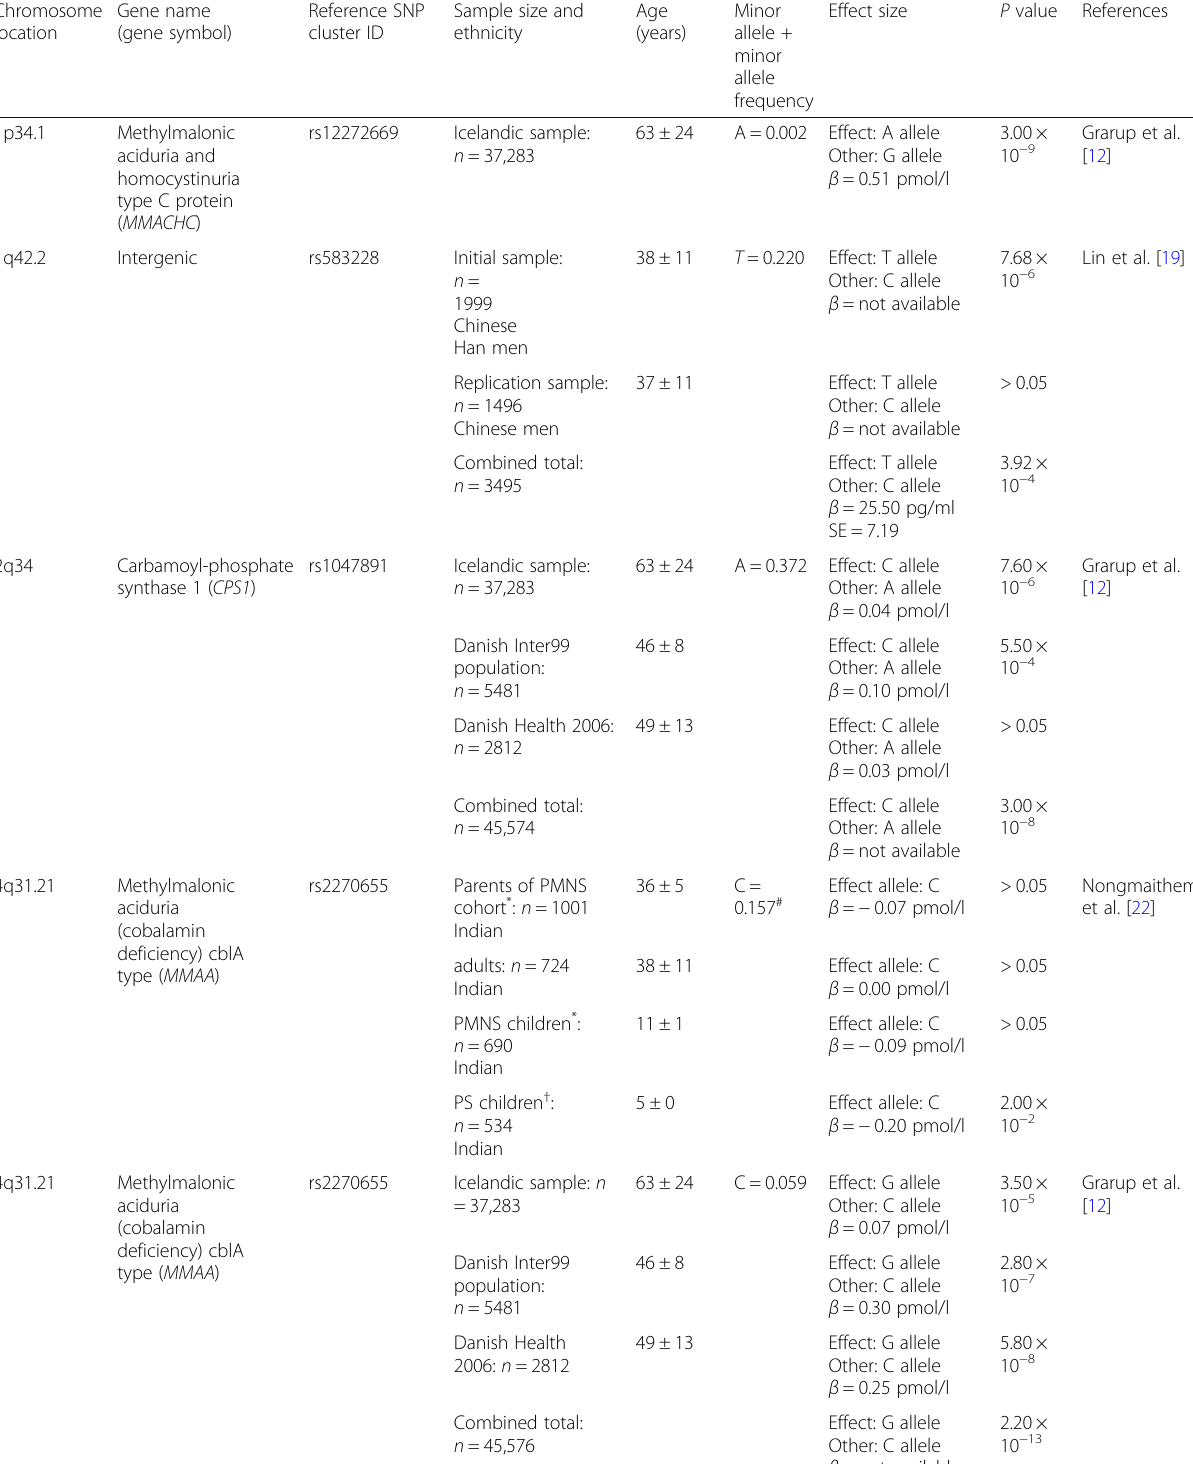
Table 1 Genome-wide association studies showing the association of SNPs with vitamin B12 concentrations. Genome-wide association studies testing the association between SNPs and vitamin B12 concentrations. The chromosome location, gene name, reference SNP cluster ID, sample size and ethnicity, mean age, observed frequency of the minor allele in the population, effect size and P value are shown in the table. The order of SNPs reflects the order of the chromosome